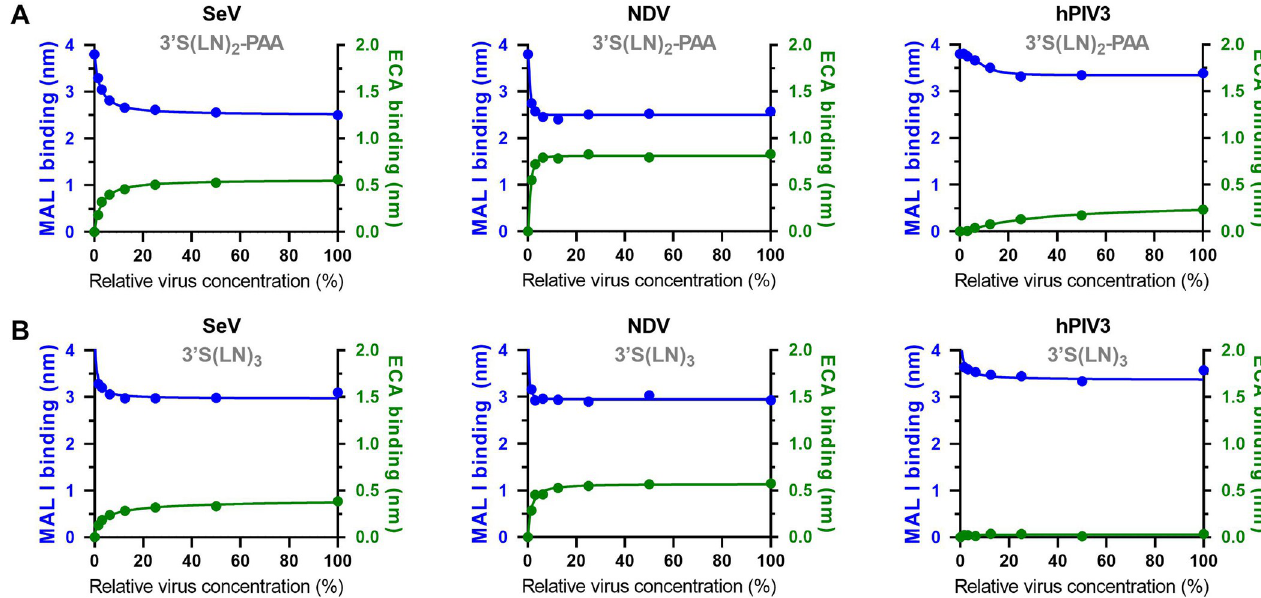
Fig 8. Characterization of receptor-surface modification by viruses using MAL I and ECA lectins. Different concentrations of SeV, NDV or hPIV3 virus particles were allowed to interact with ( A ) 3’S(LN) 2 -PAA- or ( B ) 3’S(LN) 3 - loaded sensors for 30 min (NDV and SeV) or 1h (hPIV3), followed by sensor regeneration in 10mM Tris/Glycine buffer (pH2). Presence of remaining sialoglycans was probed by analyzing binding with MAL I (left Y-axes; blue data) or ECA (right Y axes; green data).The highest virus concentration used (100%) corresponds to 2x10 10 particles/ml.